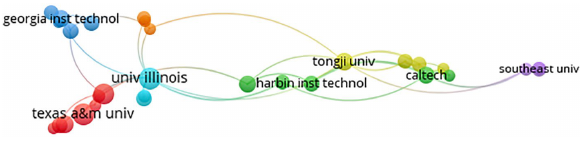
Figure 9. The collaboration network at level of